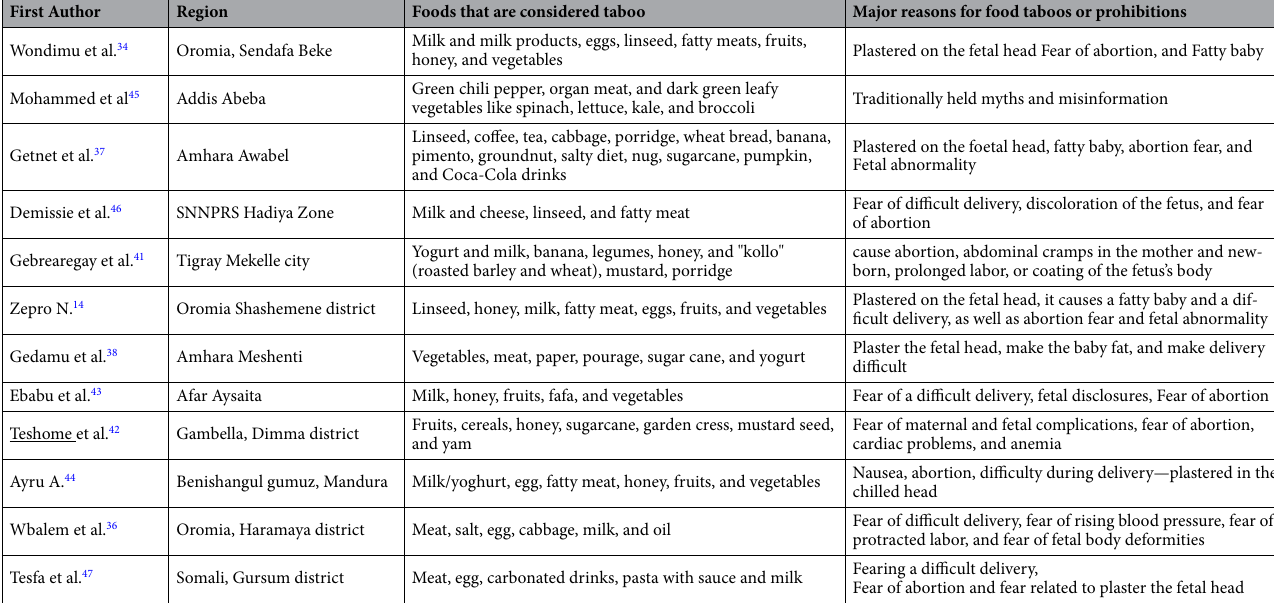
Table 5. Foods considered taboo in Ethiopia and the reasons for their prohibition among pregnant